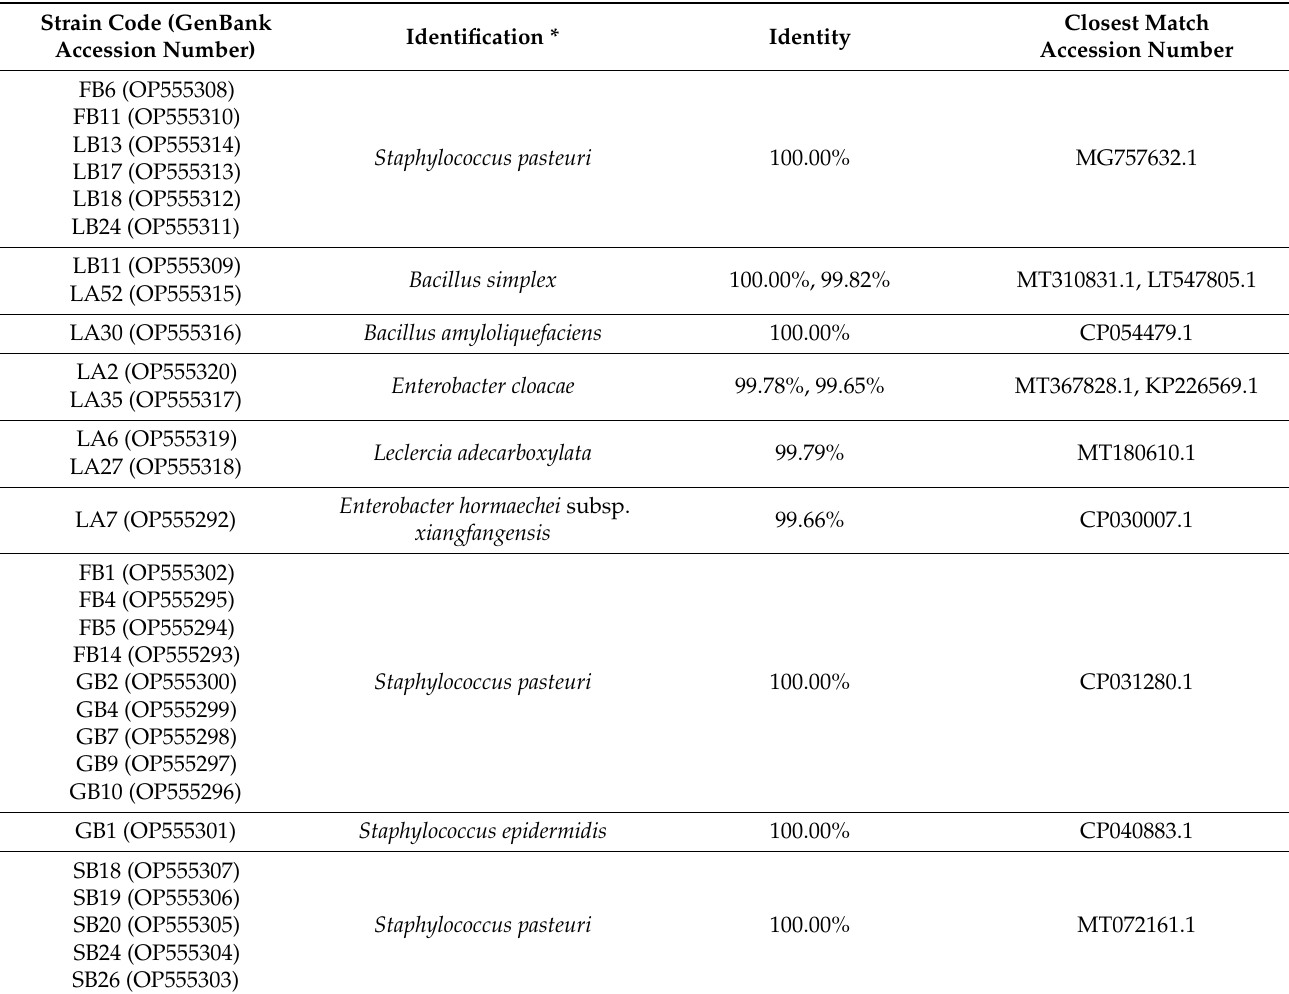
Table 1. Bacterial isolates identified from Rhizostoma pulmo jellyfish samples. Bacterial strains were identified according to their similarity to 16S rDNA region sequences in the GenBank nucleotide sequence database. The strains and the nucleotide sequence of their rDNA regions were deposited in the NCBI database; the corresponding accession numbers are